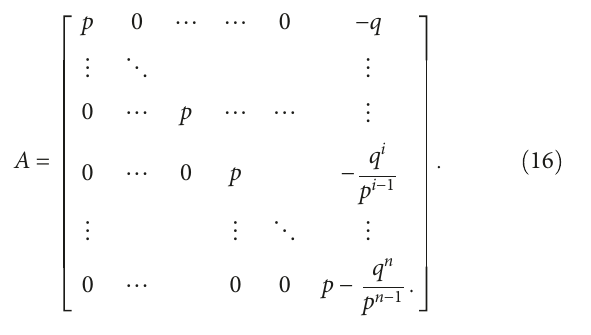
Table 1: Fuzzy rules of Δ β